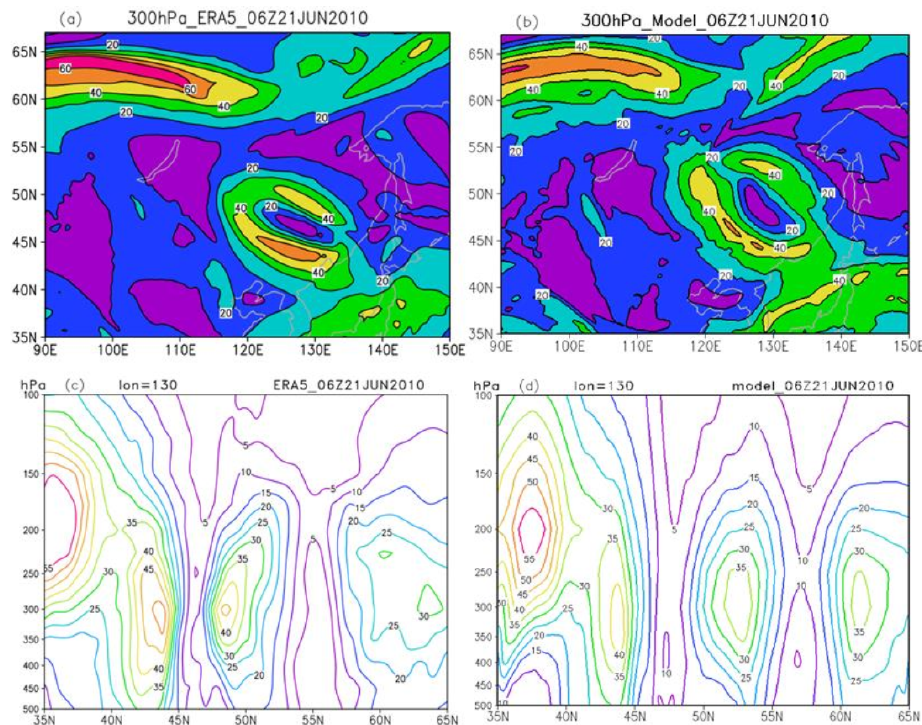
Figure A4. The 300 hPa horizontal wind (unit: m/s) from the ERA5 data ( a ), the simulation ( b ), and the meridional cross-section of horizontal wind at 130 ◦ E from the ERA5 data ( c ) and from the simulation ( d ) at 06:00 UTC on 21